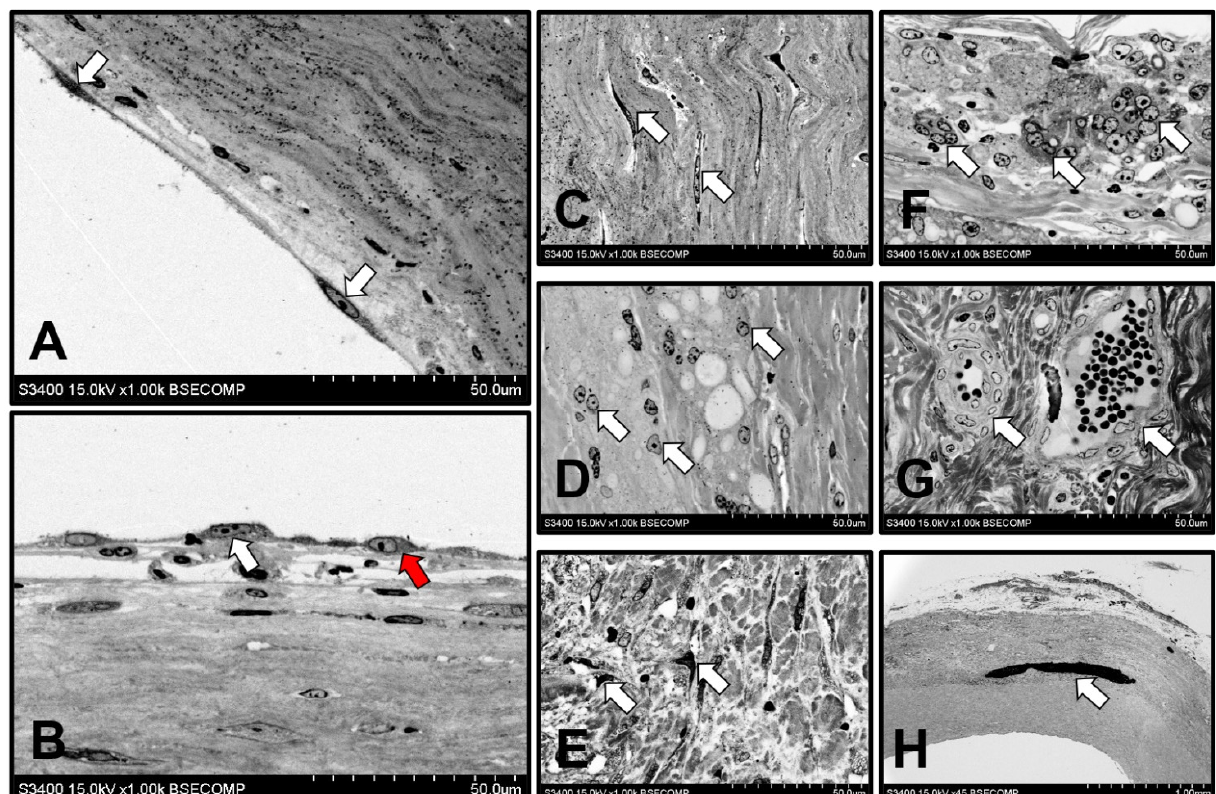
Figure 6. Backscattered scanning electron microscopy examination of the regenerated artery which replaced PHBV/PCL[VEGF-bFGF-SDF] Hep/Ilo graft 18 months postimplantation. ( A ) Monolayer of elongated endothelial cells (indicated by white arrows), ×1000 magnification; ( B ) Combination of elongated endothelial cells (white arrow) and polymorphic endothelial cells (red arrow) suggestive of a transitional phenotype, ×1000 magnification; ( C ) VSMCs in the neointima (white arrows), ×1000 magnification; ( D ) Macrophages in the medial layer (white arrows) which substituted a polymer scaffold, ×1000 magnification; ( E ) Fibroblast-like cells in the medial layer (white arrows), ×1000 magnification; ( F ) Multinucleated giant cells in the tunica adventitia (white arrows), ×1000 magnification; ( G ) Adventitial vasa vasorum (white arrows), ×1000 magnification; ( H ) Calcification on the border of neointimal and medial layers (white arrow), ×45 magnification. Representative images.